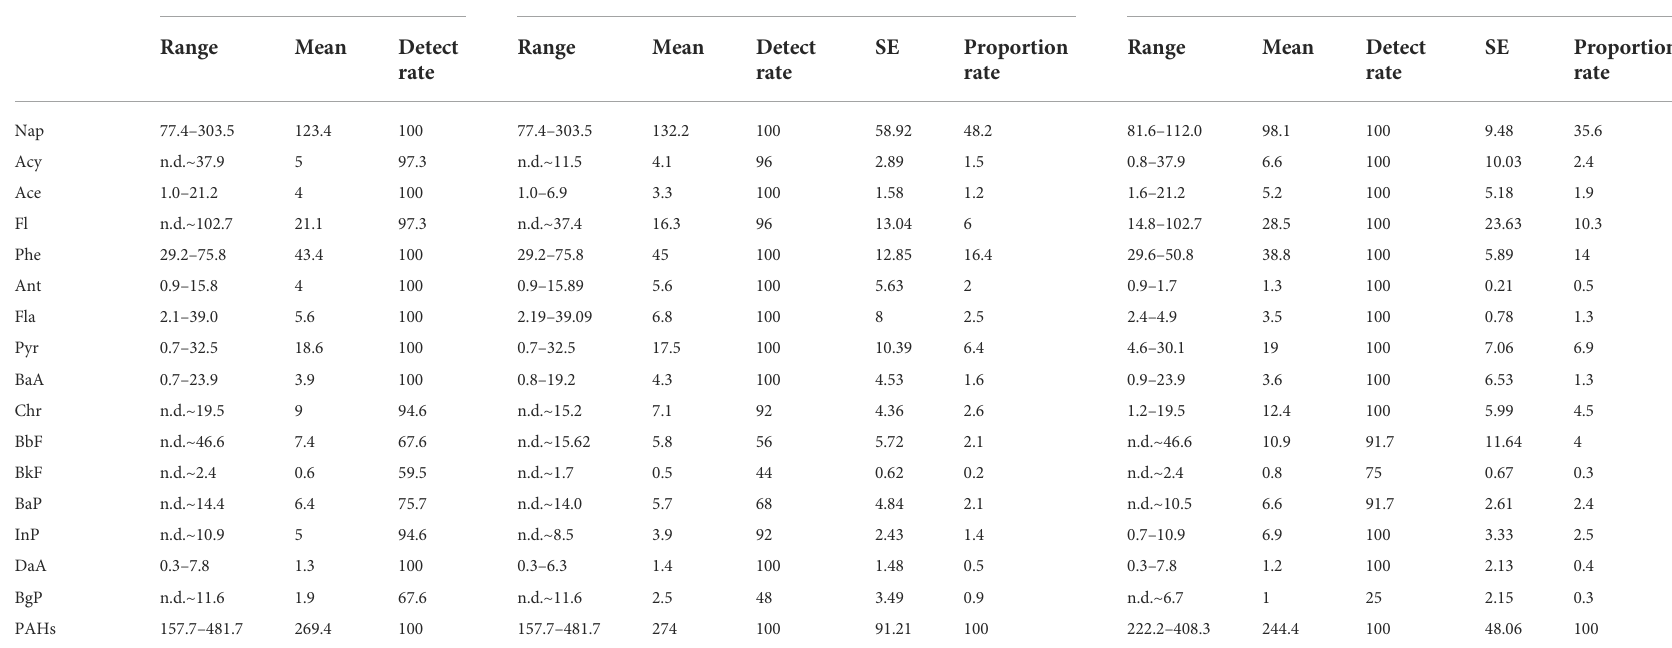
TABLE 1 PAH concentrations ( μ g kg − 1 ), detect rates and proportions in different soil samples. Compond Total soil ( n = 37) Soil from the oil fi eld ( n = 25) Soil from the estuary ( n = 12) Range Mean Detect Range Mean Detect SE Proportion Range Mean Detect SE Proportion rate rate rate rate rate